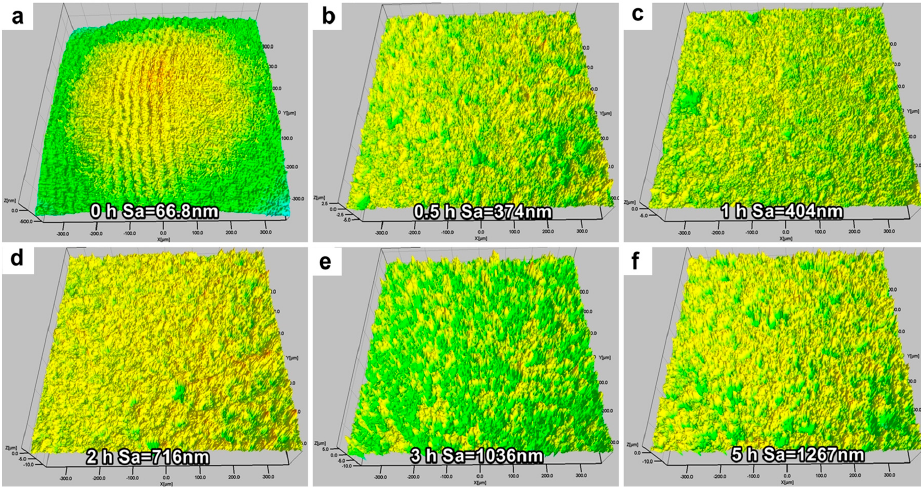
Figure 4. Surface roughness of NAB after different CE times: ( a ) 0 h; ( b ) 0.5 h; ( c ) 1 h; ( d ) 2 h; ( e ) 3 h; ( f ) 5 h.